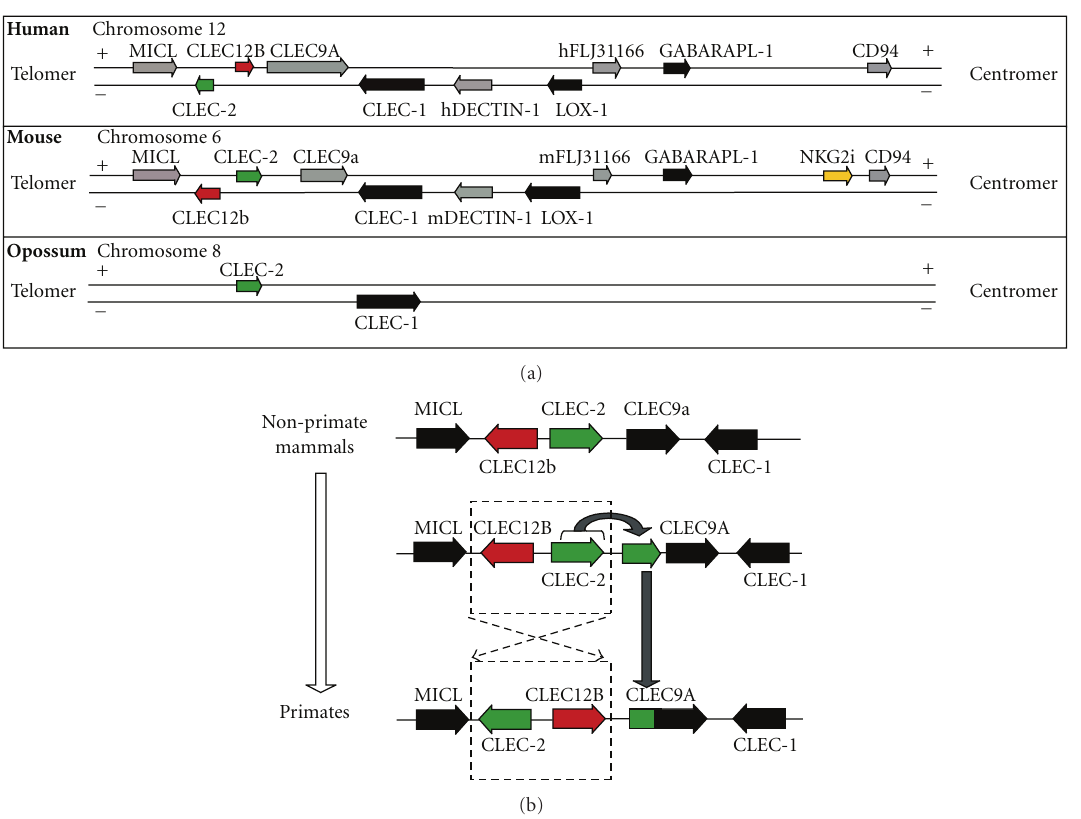
Figure 3: Organization and transcriptional orientation of the genes in the human, mouse and opossum DECTIN-1 cluster. (a) Physical map comparing the DECTIN-1 cluster in the centromeric part of the human NK complex with the corresponding region of the mouse and opossum NK complex, extending from the myeloid inhibitory C-type lectin-like receptor (MICL) gene to the CD94 gene. Linkage and orientation of the genes in the myeloid cluster of the NK gene complex are depicted. (b) Possible course of events leading from the non- primate to the primate mammalian configuration of the myeloid cluster between the genes encoding MICL and CLEC-1. Modified and reprinted with permission of John Wiley & Sons, Inc. © 2010 from